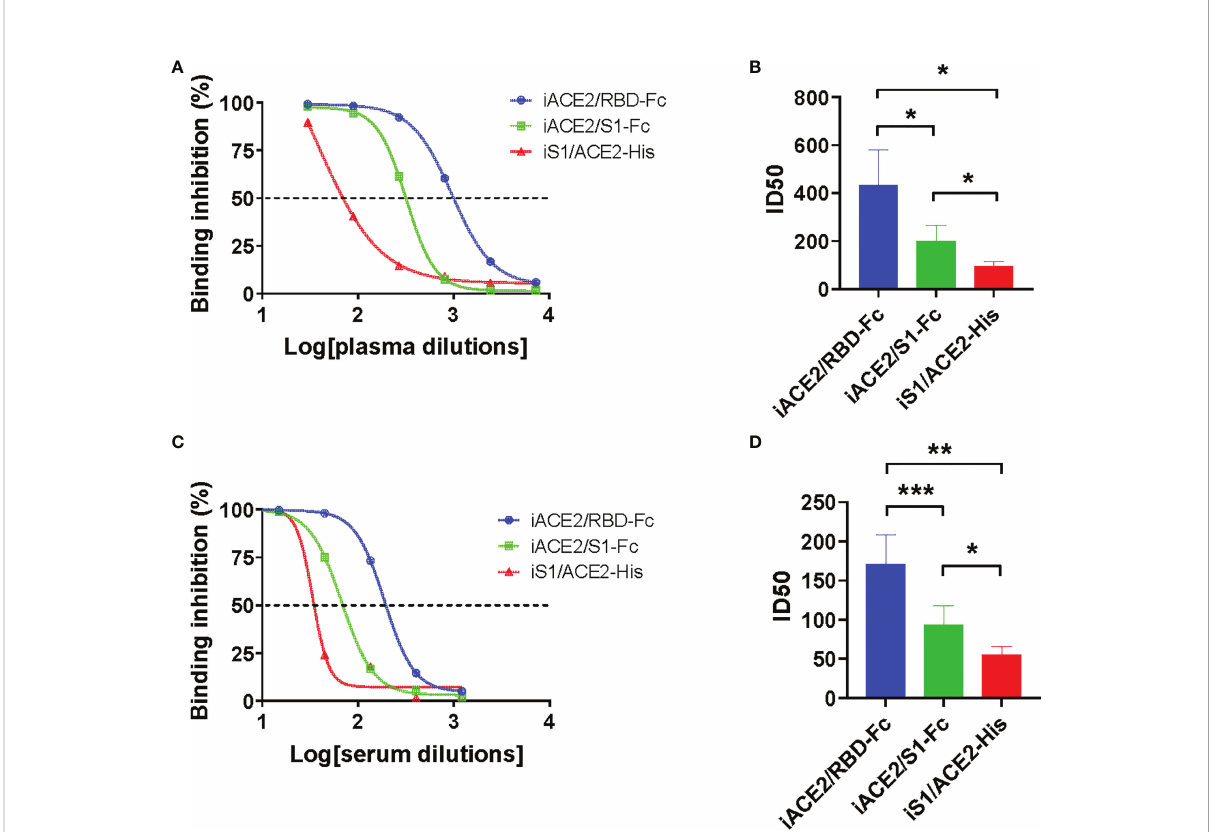
FIGURE 3 Comparison of ID50 values determined by models of iACE2/RBD-Fc, iACE2/S1-Fc and iS1/ACE2-His. Three representative sample dilution response inhibition curves of a convalescent plasma sample and a vaccine serum sample determined by the models of iACE2/BD-Fc, iACE2/S1- Fc and the iS1/ACE2-His were plotted and shown in (A, C) , respectively. The ID50 values of 12 convalescent plasma samples and 18 vaccine serum samples determined by the three models were compared and shown in (B, D) , respectively. The 18 vaccine serum samples were randomly selected from the samples collected after two weeks post the 2nd dose of immunization. P<0.05, 0.01 and 0.001 are represented as *, ** and ***,